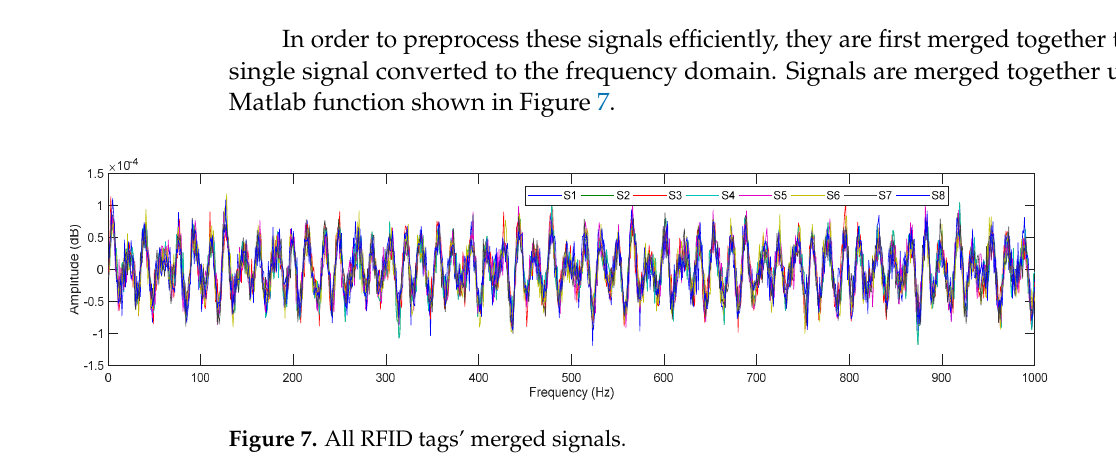
Figure 8. Original signal with noise using FFT. The multipath effect of RFID signals between two transceivers was treated as noise in this investigation. It is a form of signal reception in which radio signals travel over two or more pathways to reach the antenna. Butterworth filtering was presented as a solution to this problem. The multipath effect was minimized by removing the phase offset data from the merged input signal. Figure 9 shows a filtered image. Figure 9. Signal after Butterworth filtering.